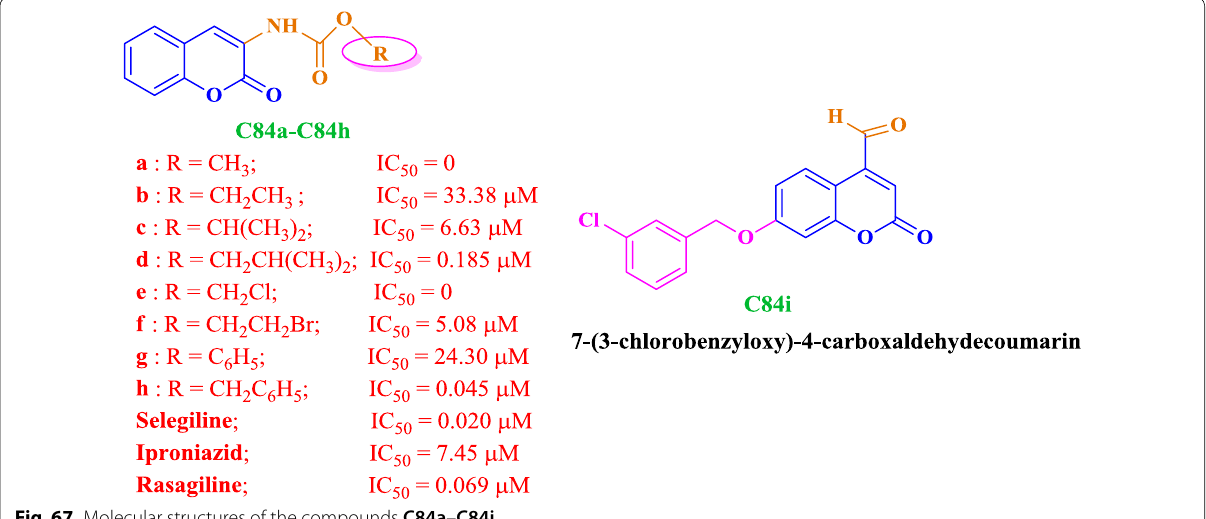
Fig. 67 Molecular structures of the compounds C84a –